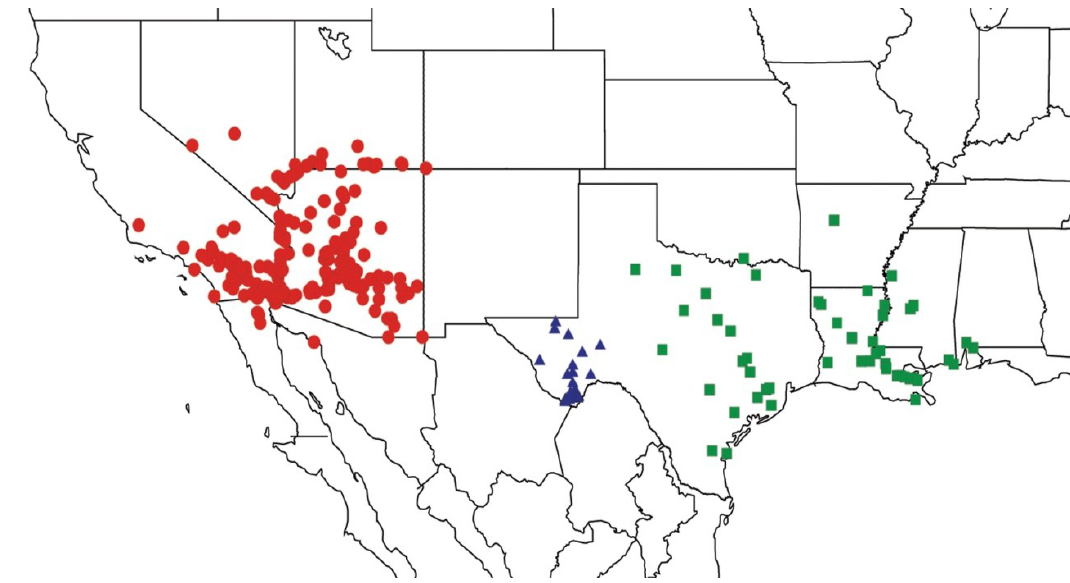
Figure 6. Distribution of Dicerprocta apache (red circles), D. bibbyi (blue triangles) and D. bequaerti (green